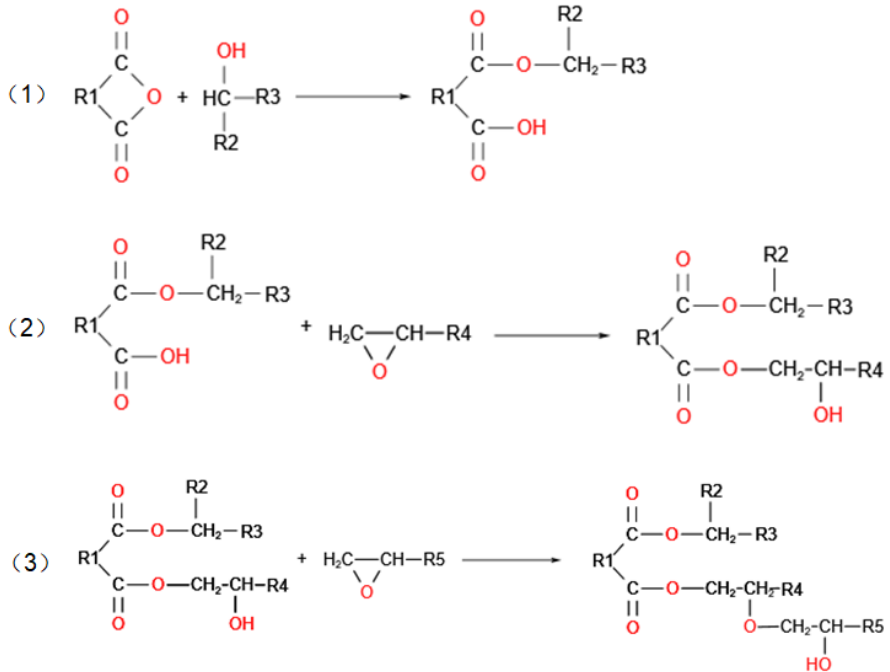
Figure 1. Curing reaction mechanism of epoxy resin: (1) the anhydrides are ring-opened and react with hydroxyl groups in epoxy resin to form monoesters containing carboxylic acids; (2) the carboxylic acid reacts with the epoxy group to form new hydroxyl groups; (3) the hydroxyl generated in the previous step reacts with the epoxy group to generate new hydroxyl, and the generated hydroxyl also further reacts with the anhydride group to generate carboxylic acid.